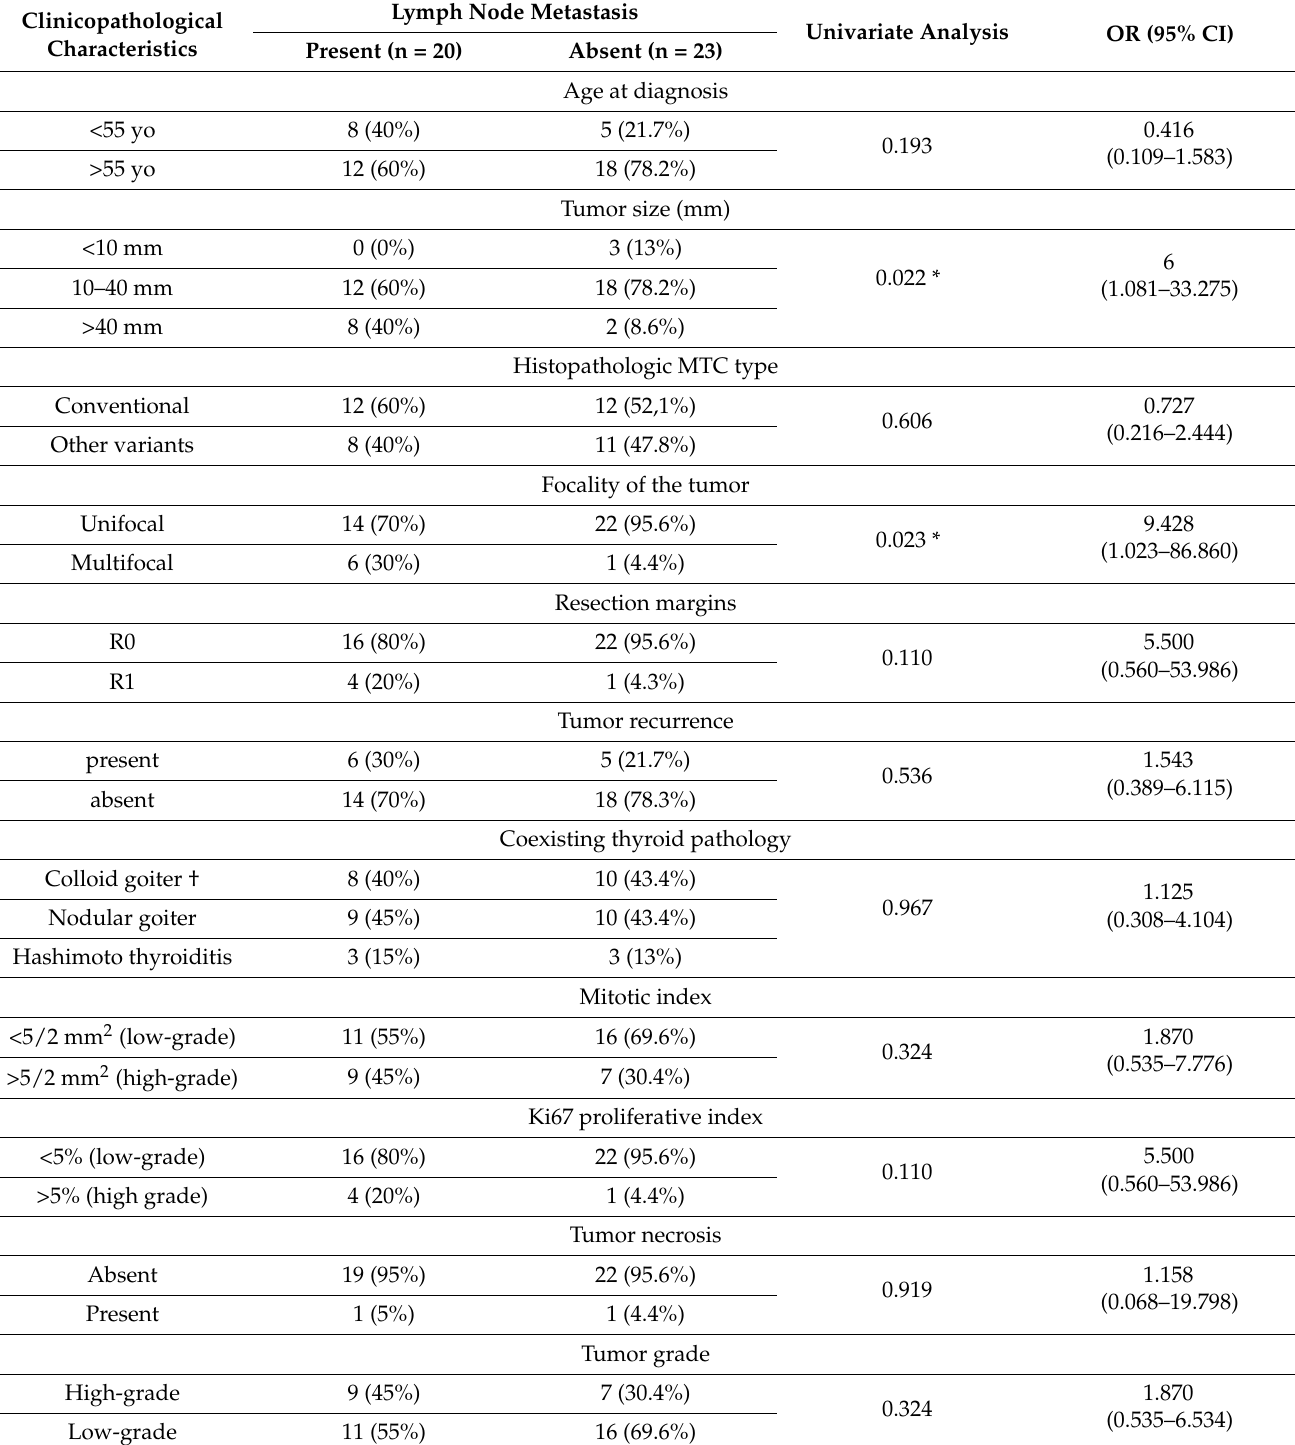
Table 6. Clinicopathological characteristics of MTC according to lymph node